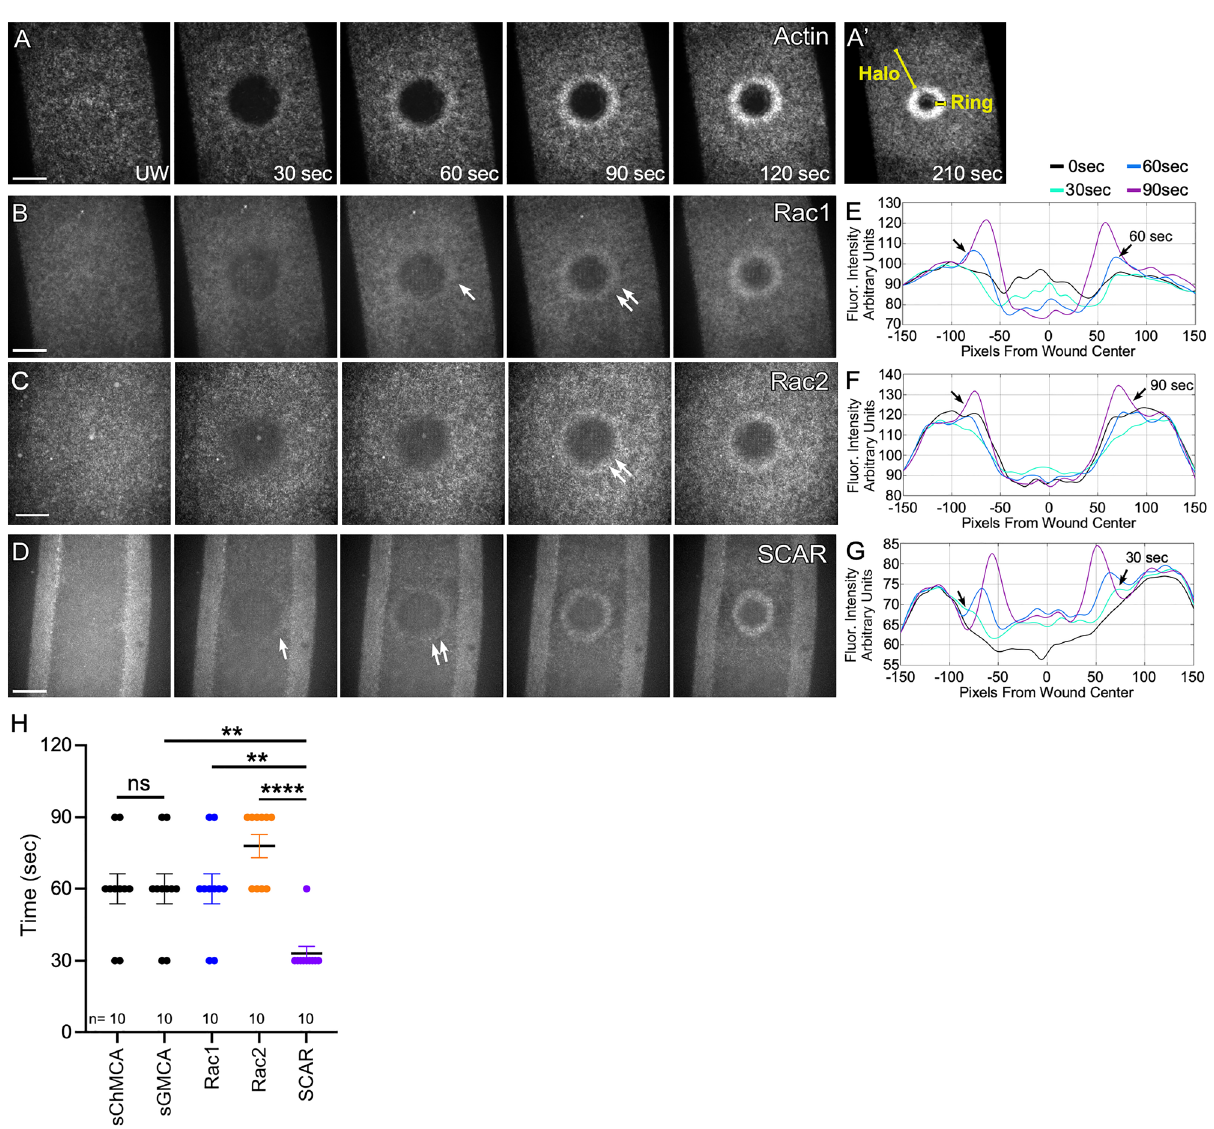
Figure 1. SCAR is recruited to cell wounds faster than Rac1 or Rac2. Confocal projection images of embryos expressing an actin reporter (sGMCA; A - A’ ) or co-expressing mCherry-Rac1 and sGMCA ( B ), GFP-Rac2 and sStMCA ( C ), and GFP-SCAR and sStMCA ( D ). Times post-wounding are indicated. UW = unwounded. Arrows indicate recruitment to the wound periphery. ( E – G ) Fluorescence intensity (arbitrary units) profiles across the wound area over time for the images shown in ( B – D ), respectively. ( H ) Dotplot of initial actin, Rac1, Rac2, and SCAR recruitment to wounds. Scale bars: 20